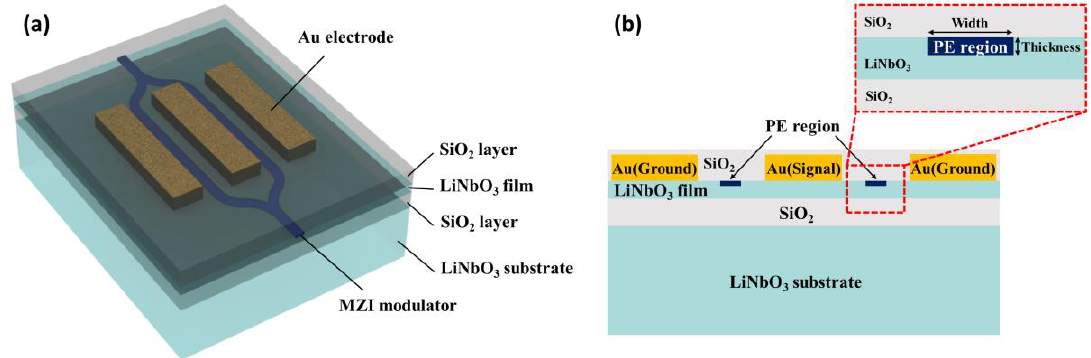
Figure 1. ( a ) Schematic of the M-ZI. ( b ) The cross-sectional schematic of the M-ZI and the Figure 1. (a) Schematic of the M-ZI. (b) The cross-sectional schematic of the M-ZI and the channel channel waveguides. Table 1. Refractive indices of the material in simulation ( λ = 1.55 μm).